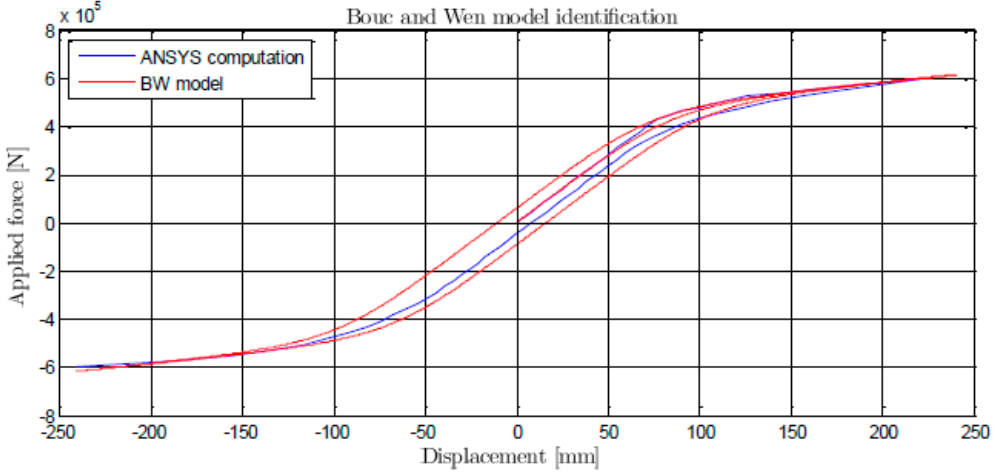
Figure 3: Comparison of the identified BW model with the ANSYS results (2 nd attempt).